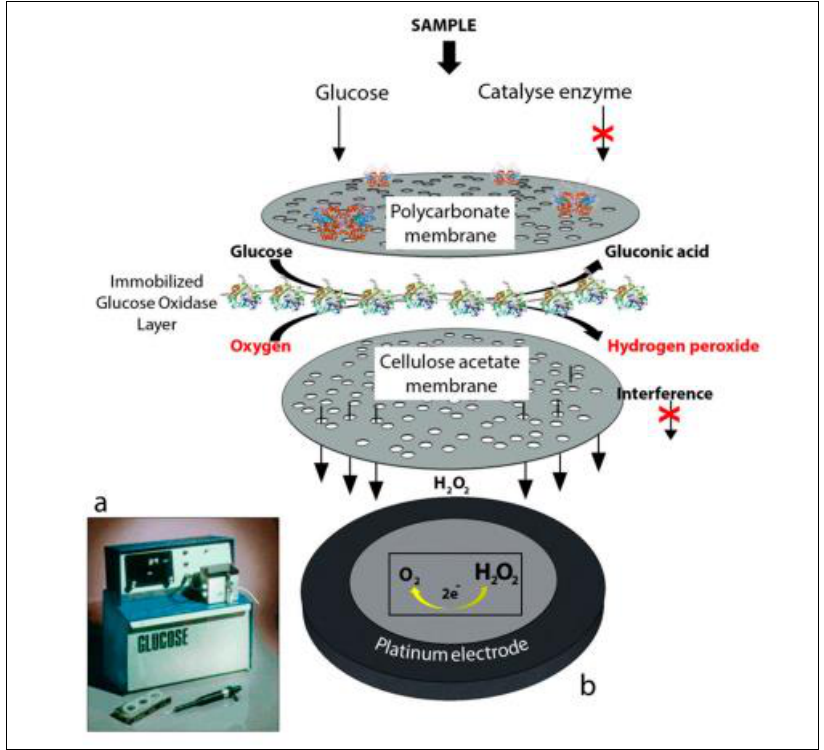
Figure 2. ( a ) YSI 23A Bio-Glucose Sensor. Reprinted with permission from Ref. [26]. 2003, Elsevier (Amsterdam, The Netherlands). ( b ) two-membrane system for glucose detection. Reprinted with permission from Ref. [27]. 2005, Elsevier.